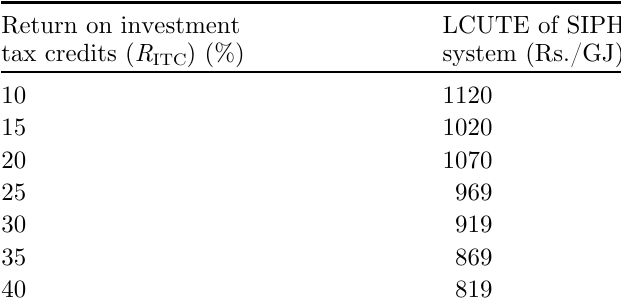
Table 4. LCUTE at different rate of ITC. Return on